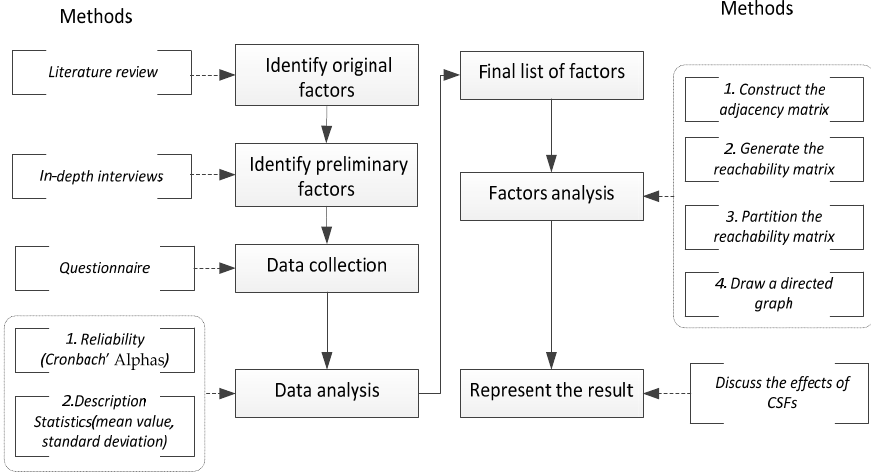
Figure 1. Flowchart of the methodology.